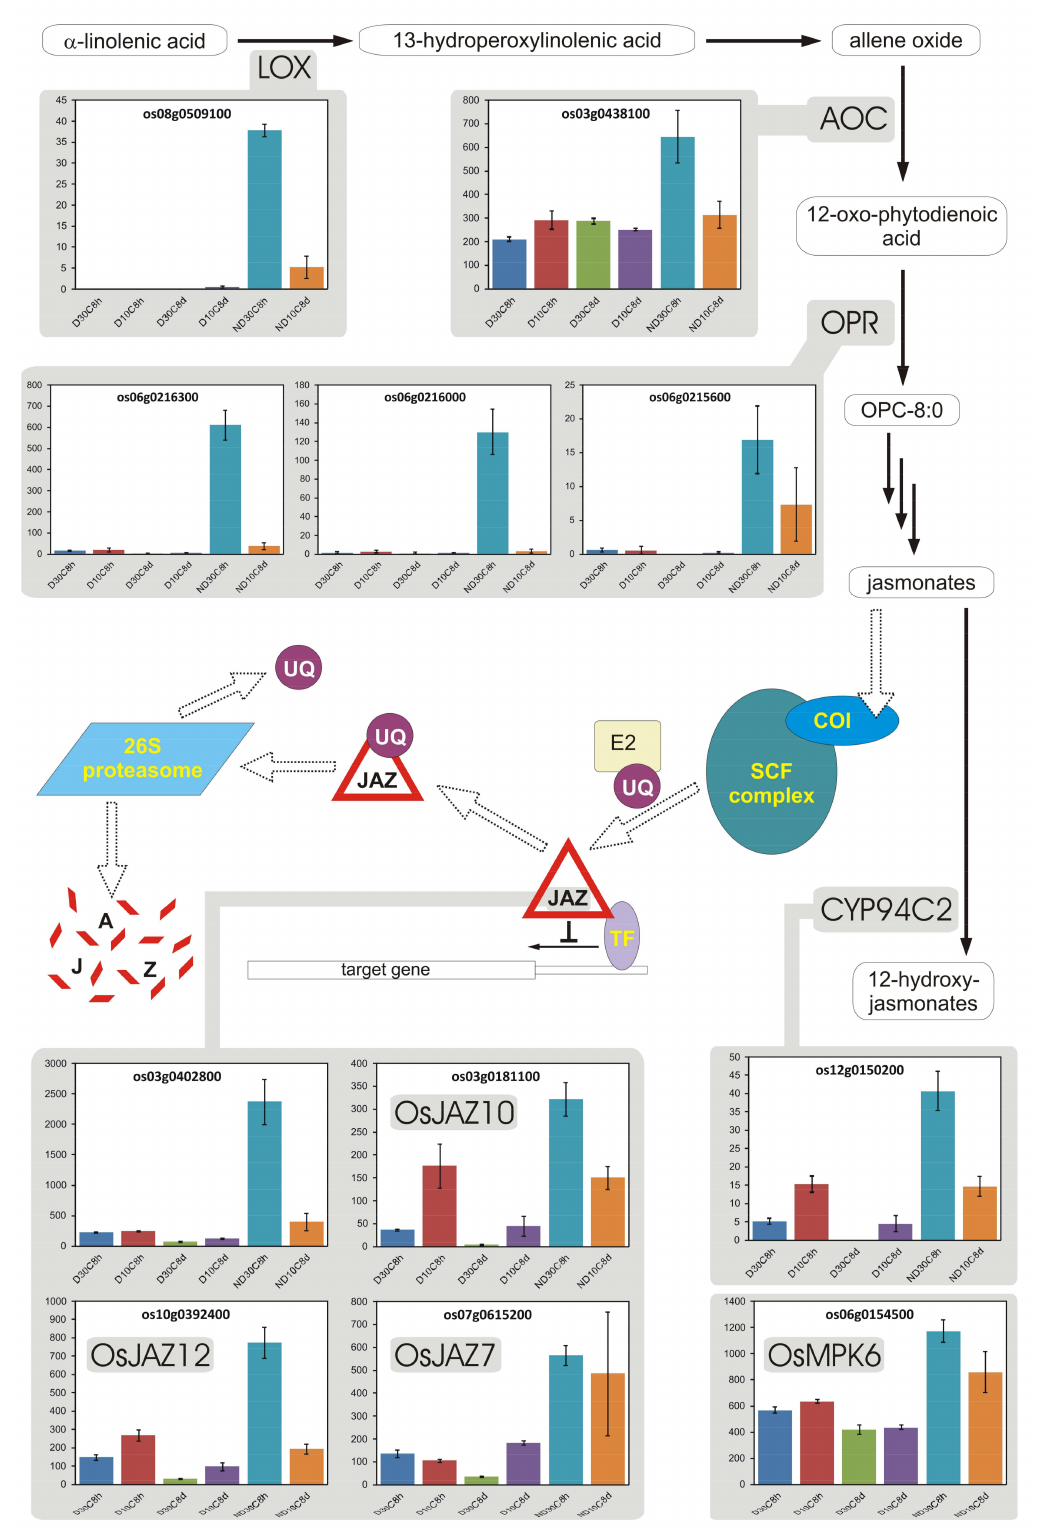
Figure 5. Expression levels (left scale on the y-axis of each plot) of genes involved in jasmonate